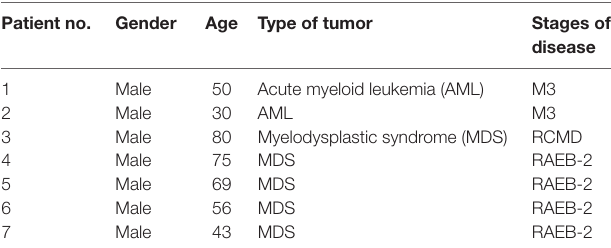
Table 1 | Patient clinical